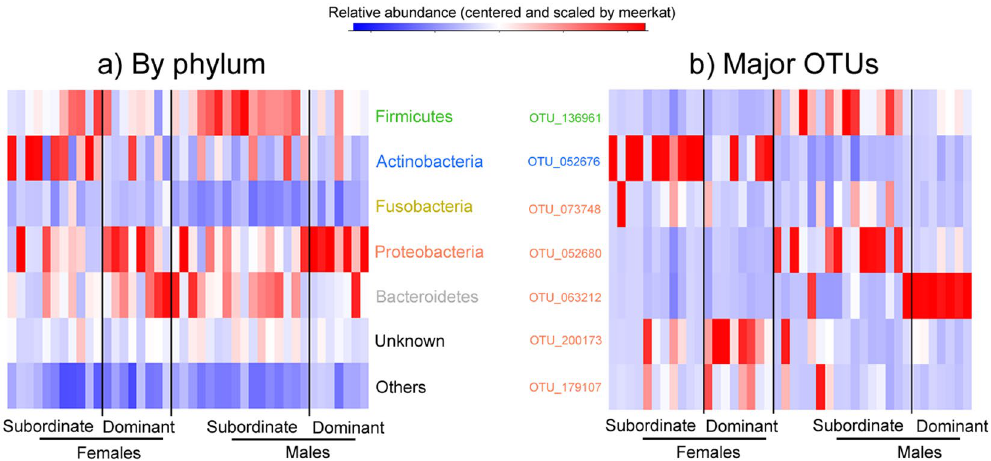
Figure 5. Heatmaps of the relative abundance of OTU sequences for ( a ) the different bacteria phyla and ( b ) the major OTUs (average percent abundance > 2%) present in the anal-pouch mixtures of dominant and subordinate, female and male